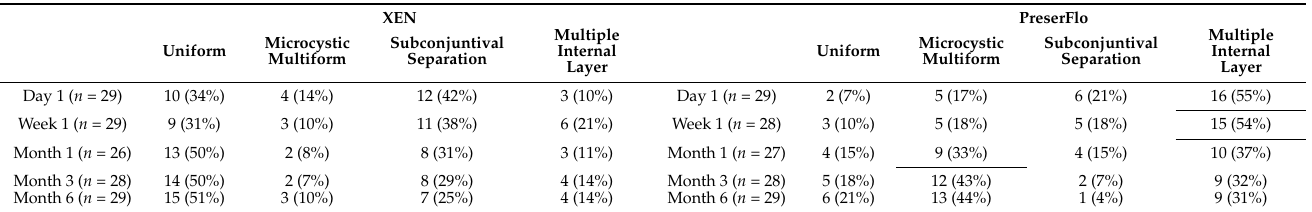
Table 3. Bleb morphology classification of the XEN and PreserFlo blebs at day 1, week 1, month 1, month 3 and month 6 follow